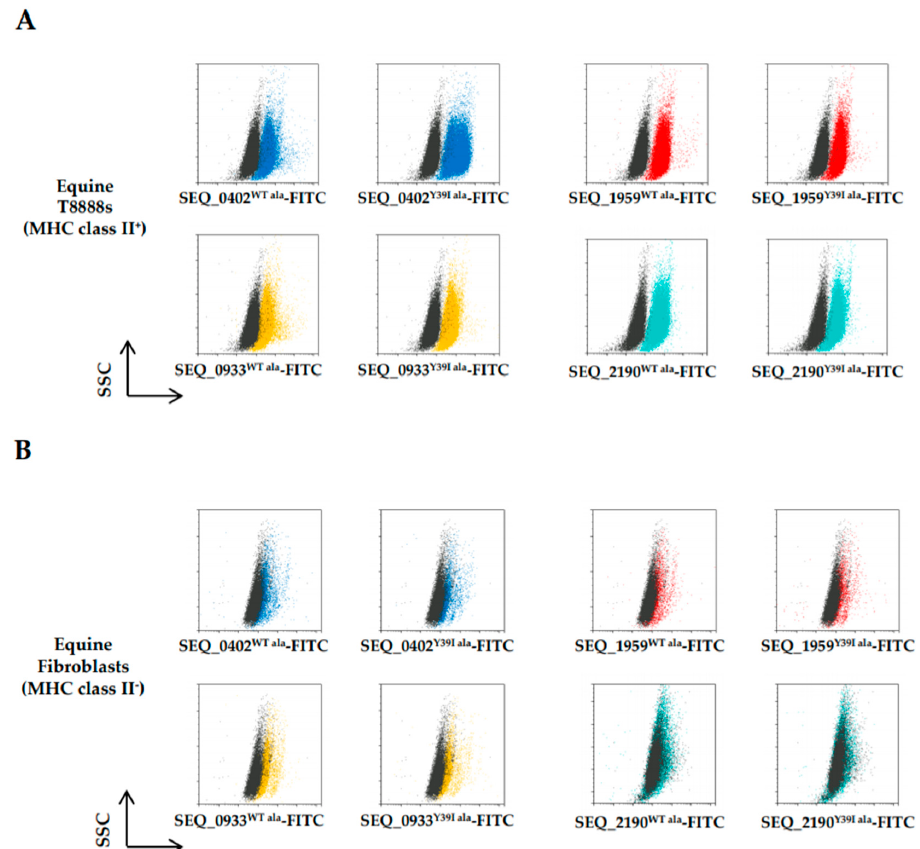
Figure 4. S. equi surface proteins fused to SpeS WT or SpeS Y39I retain their ability to bind to MHC class II molecules in vitro. Flow cytometry analysis of SEQ_0402 (blue), SEQ_1959 (red), SEQ_0933 (yellow) and SEQ_2190 (aqua green) fusion proteins binding to MHC class II molecules. ( A ) Equine ( B ) fibroblasts were incubated for 20 min at 4 ◦ C with the FITC-labelled proteins, washed and the